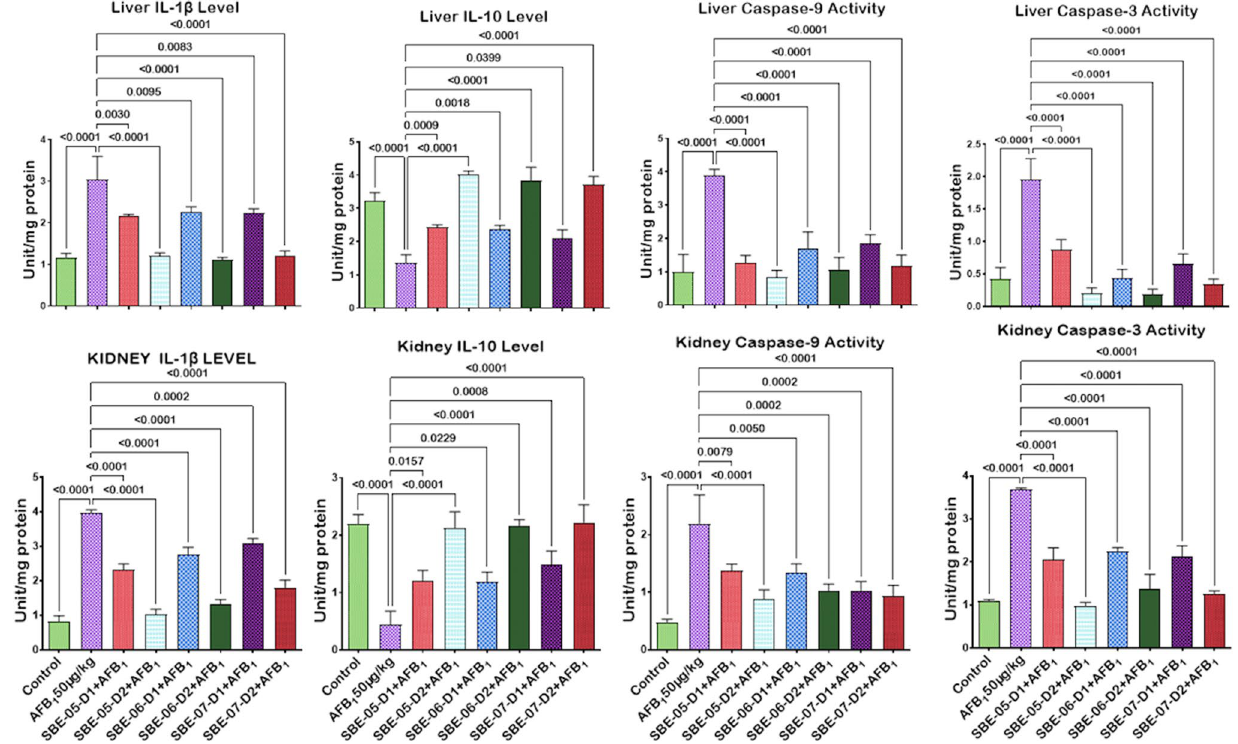
Figure 8. Effect of SBE-05, SBE-06 and SBE-07 on the levels of IL-1β, IL-10, caspase 9 and caspase 3 in the liver and kidney of rats treated with AFB 1 for 28 d. Experimental doses: AFB 1 at 50 μg/kg; SBE-05-D1 at 5 mg/ kg; SBE-05-D2 at 10 mg/kg; SBE-06-D1 at 5 mg/kg; SBE-06-D2 at 10 mg/kg; SBE-07-D1 at 5 mg/kg; SBE-07-D2 at 10 mg/kg. Values are expressed as mean ± SD for 6 rats per treatment cohorts. Connecting lines indicate groups compared to one another, the significance level was set at (p < 0.05) ; * p < 0.05; ** p < 0.01; *** p < 0.001; **** p < 0.0001: indicates the level of significance; p > 0.05: not significant. AFB 1 Aflatoxin B1; D1 lower dose; D2 higher dose; IL-1β Interleukin-1beta; IL-10 Interleukin-10.